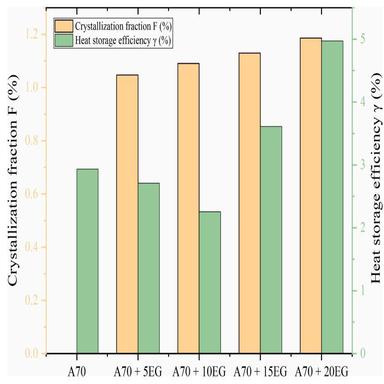
Variation in crystallization fraction and the heat storage efficiency at different weight fractions of EG added to base PCM.